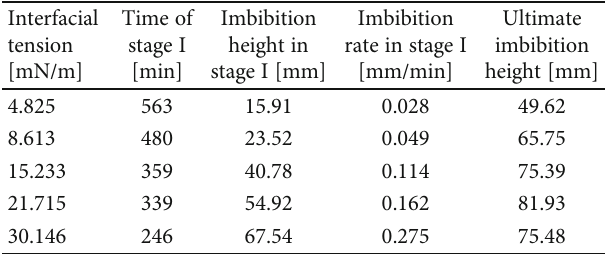
Table 1: Results of imbibition experiments under di ff erent interfacial tensions with a salinity of